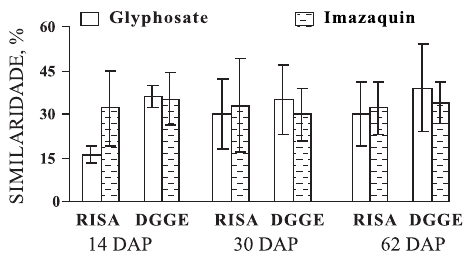
Figura 3. Similaridade dos perfis bacterianos obtidos por DGGE e RISA em amostras de rizoplano de soja cultivada em solo tratado com herbicidas à base de glyphosate e imazaquin, em relação ao tratamento controle. As barras no gráfico indicam o erro-padrão entre os blocos. (DAP: dias após aplicação dos